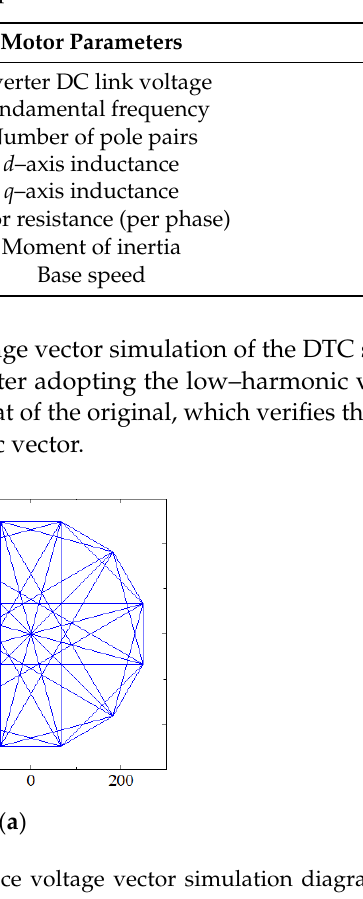
F ( b ) Figure 17. Dual three − phase current simulation diagram. ( a ) Traditional DTC current simulation diagram. ( b ) Low − harmonic DTC current simulation diagram. In the simulation, the given speed is 3000 r/min, the fundamental frequency of the motor is 100 Hz, and the phase current fast Fourier transform (FFT) analysis results are presented in Figure 16. After replacing the large vector with a low-harmonic vector, the current harmonic content decreases from 36.6% to 4.49%, as shown in Figure 18. The har- monic suppression effect is remarkable.